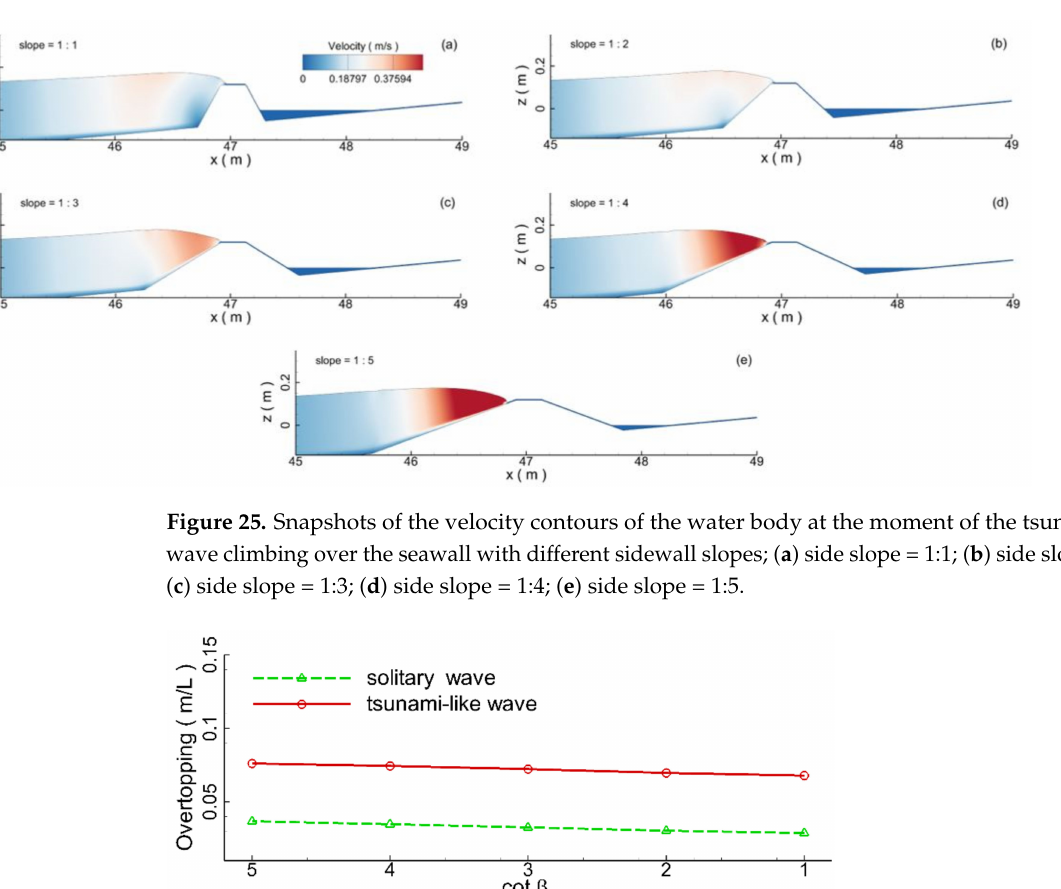
Figure 24. Computational layout for seawalls with different side slopes.